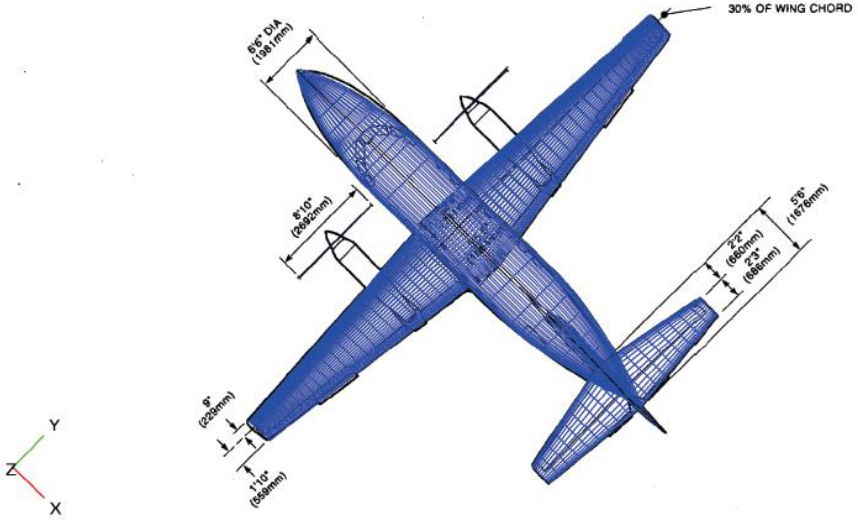
Figure 4. Reference model top view (overlaid on the aircraft maintenance manual [25] view).